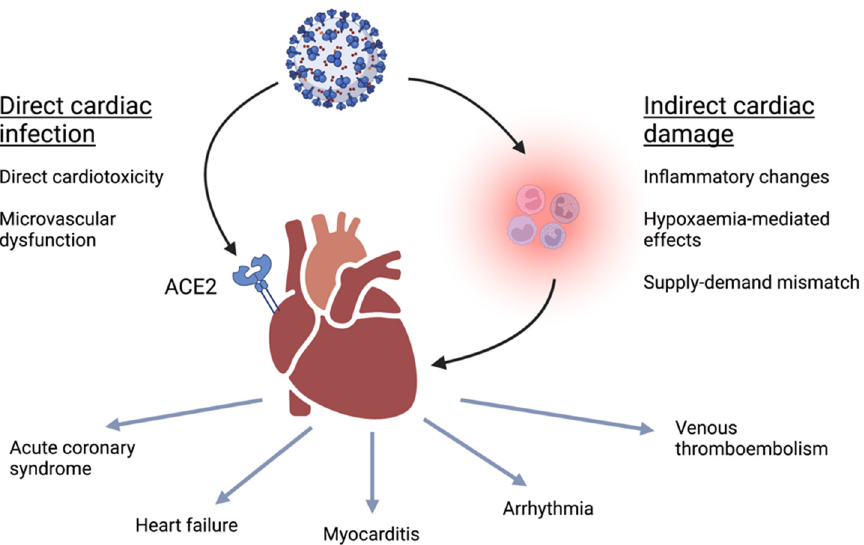
Figure 1. An illustration of the potential mechanisms underlying COVID-19 complications in the heart. A schematic of direct and indirect mechanisms through which COVID-19 causes cardiac complications. The COVID-19 virus (shown at the top of the figure) may directly bind to cardiomyocytes and endothelial cells (left) to cause direct cardiac infection and cardiotoxicity. Indirect damage may also occur (right), with downstream inflammatory and hypoxaemic mechanisms. In the lower figure, we show the consequent cardiac complications that may result. ACE2 = angiotensin-converting enzyme 2. Created with BioRender.com with permission.